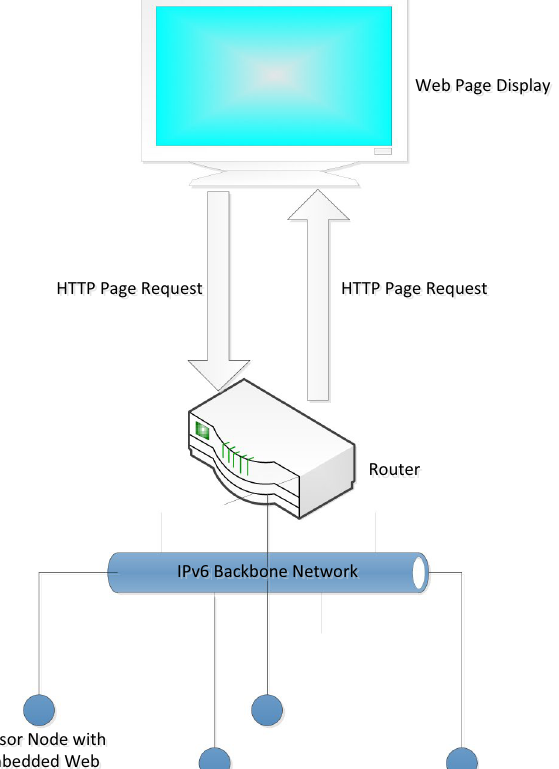
Figure 8. Network topology of the embedded web